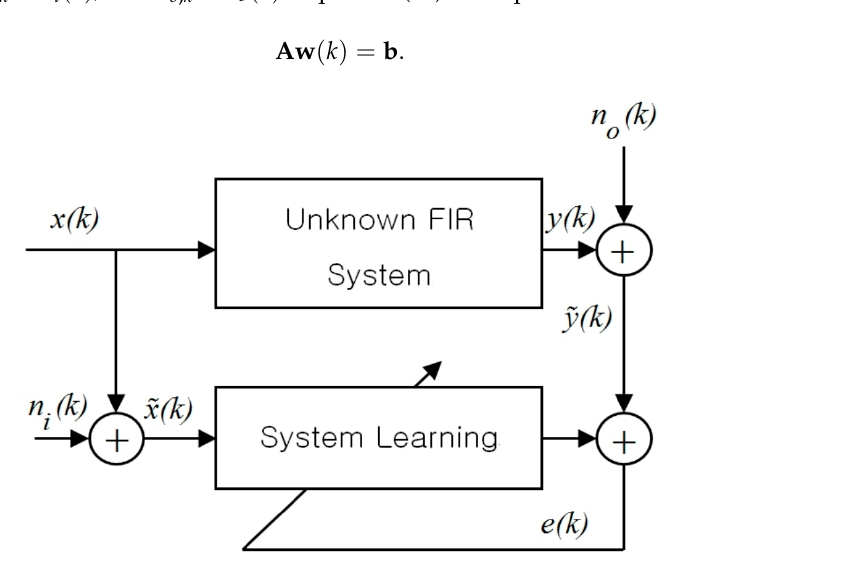
Figure 2. The model of a noisy input and noisy output